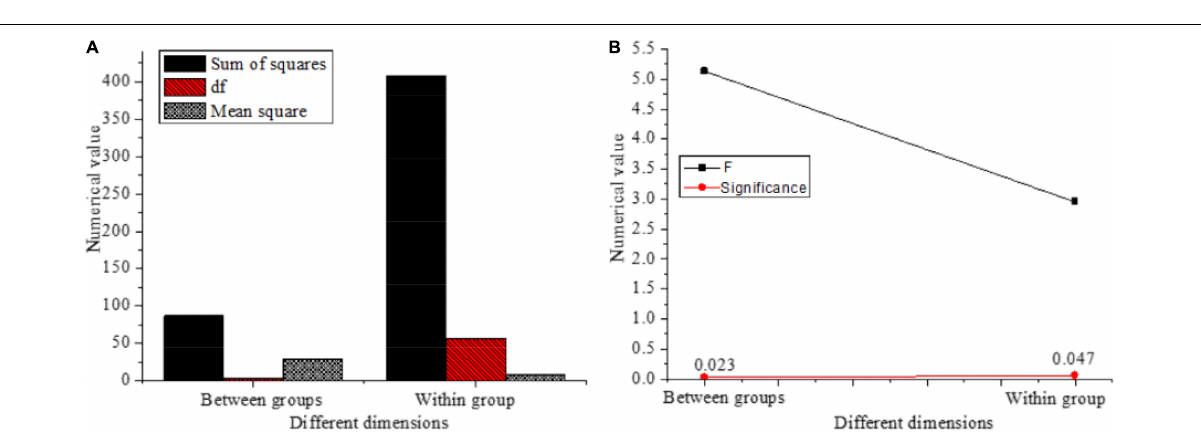
FIGURE 8 | Influence of the genders of entrepreneurs on different variables. (A) t -test results of mean equation of different variables affected by entrepreneur gender. (B) Levene test results of variance equation of different variables affected by entrepreneur gender.